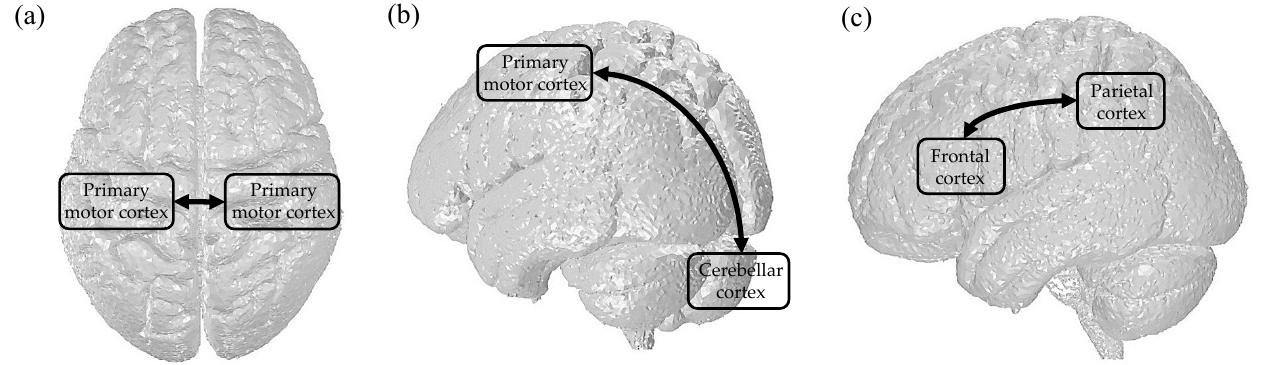
Figure 1. tACS targeting brain communication. ( a ) between bilateral primary motor cortices. ( b ) between primary motor cortex and cerebellar cortex. ( c ) between frontal and parietal